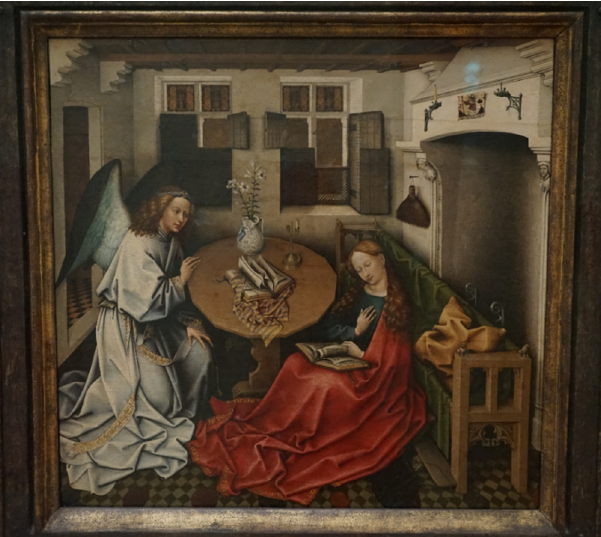
Figure 4. Master of Flémalle (Robert Campin?), Annunciation , ca. 1425. Tempera on oak, 61 × 63.7 cm. Brussels, Musées Royaux des Beaux-Arts de Belgique. © author.